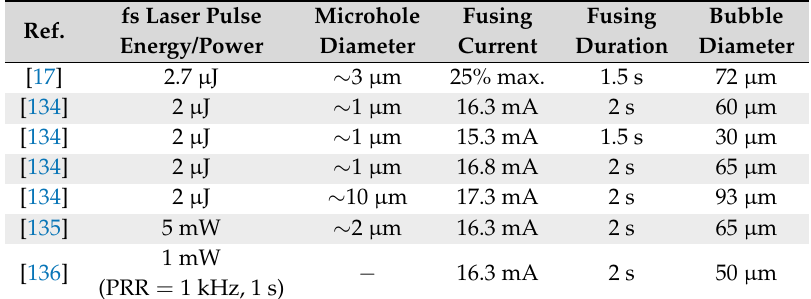
Table 5. Different manufacturing parameters of in-fiber circular air cavities according to the method depicted in Figure 12b. fs Laser Pulse Microhole Fusing Fusing Bubble Ref. Energy/Power Diameter Current Duration